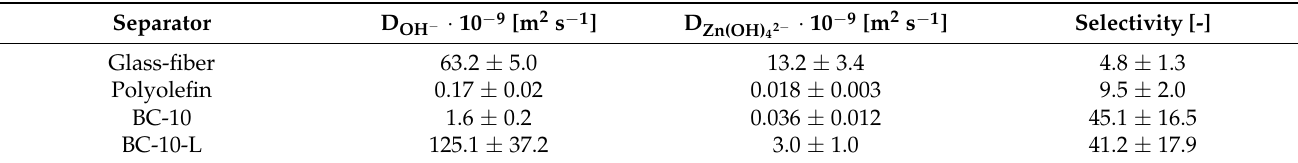
Table 2. Diffusion coefficients and selectivity for hydroxide and zincate ions for the investigated separators.